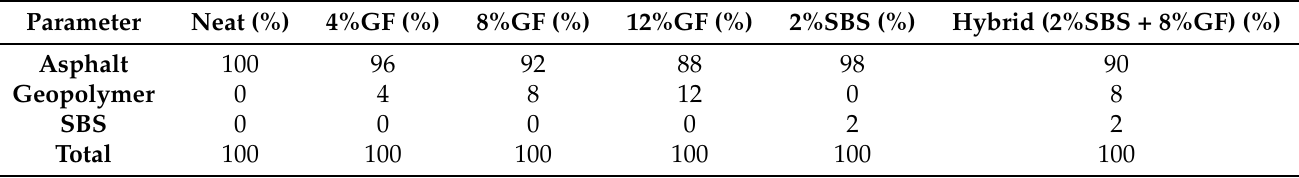
Table 2. Geopolymer and SBS percentages in the modified asphalt binders.